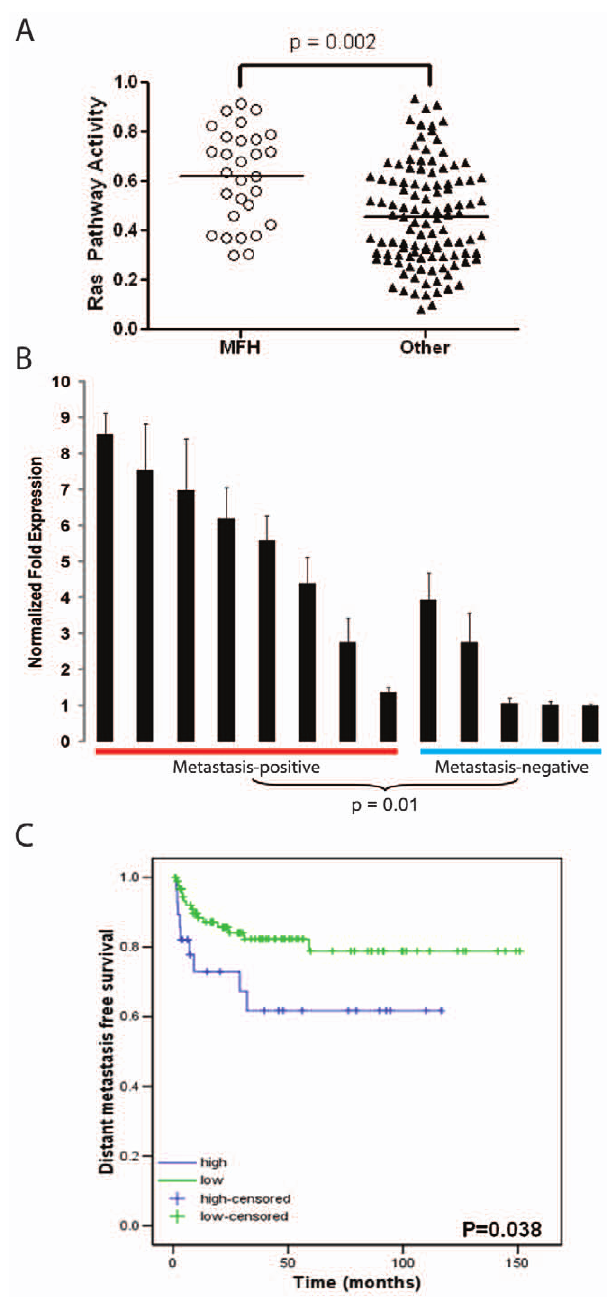
Figure 2. The LSL-Kras G12D ; Trp53 Flox/Flox mouse model of soft tissue sarcoma provides insight into human MFH. A , An oncogenic Ras signature is enriched in human MFH samples compared to other types of soft tissue sarcoma (p=0.002, non-parametric Mann- Whitney test). B , Q-RT-PCR for Foxm1 in murine soft tissue sarcomas correlates with metastatic potential of primary tumors (p=0.01, two- tailed student’s T-test, scale bars represent one standard deviation). C , FOXM1 expression in a tissue microarray correlates with metastasis free survival in human MFH (p=0.038).